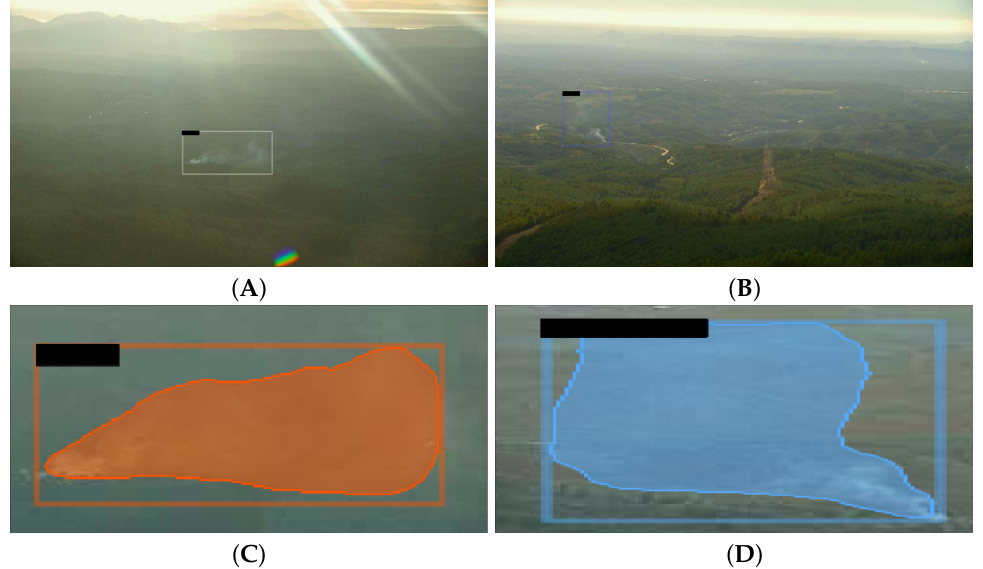
Figure 4. Examples of true positives detected and their segmentation outlines. ( A ) shows a detected bounding box (with 89.7%) of a mid smoke column and the respective segmentation in ( C ), which was later identified as a smoke object with a probability of 77.5%. ( B ) shows another detected bounding box (with 66.1%) of a hrz smoke column and respective segmentation in ( D ), which was later identified as a smoke object with 87.4%.